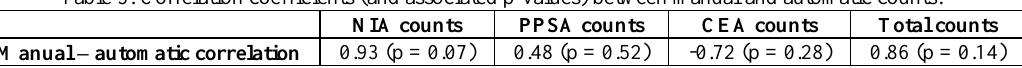
Table 3: Correlation coefficients (and associated p-values) between manual and automatic